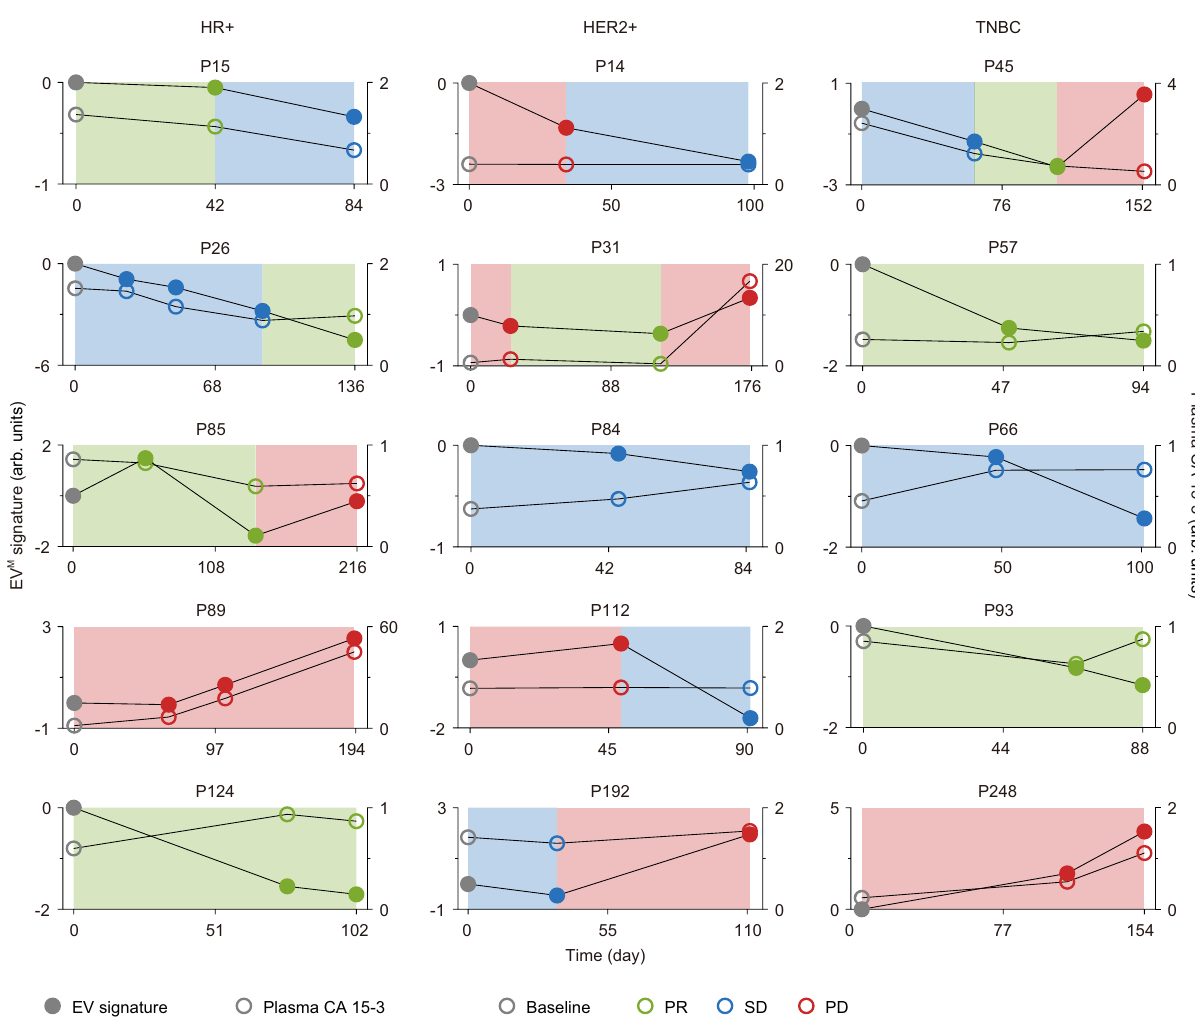
Fig. 6 Comparison of the EV M signature and plasma CA 15-3 in longitudinal monitoring for MBC. The EV M signature, CA 15-3 level, and therapeutic response were summarized for MBC patients in different BC subtypes ( n = 5 for each subtype). The cumulative sum of the EV M signature at each time point was calculated and plasma CA 15-3 level was normalized by the cutoff value of 25 U mL − 1 . The solid gray, green, blue, and red dots indicate the EV M signature at the baseline, PR, SD, and PD, respectively. The void gray, green, blue, and red dots indicate the plasma CA 15-3 at the baseline, PR, SD, and PD, respectively. Source data are provided as a Source Data fi center were locally heated by a 1480-nm laser (Changchun Laser Optoelectronics Technology, China) with a power of 190 mW for 10 min to allow size-dependent enrichment of EVs. The fl uorescence intensities before and after laser irradiation were captured by a sCMOS (95B, Photometrics, Canada) with 2× 2 pixels binning and an exposure time of 50ms, and recorded using ImageJ (1.52a, NIH). The experiments were performed in the dark to avoid photobleaching. EV titration experiments . EVs isolated from plasma of an untreated MBC patient were suspended in 1× PBS at different concentrations ranging from 3.2× 10 6 mL − 1 to 10 10 mL − 1 and incubated with Cy5-conjugated single-stranded DNA (ssDNA, 0.1 μ M) aptamers targeting CEA at 25°C for 2 h. TAS was then used to detect the expression level of CEA on EVs with different concentrations. As shown in Fig. 1e, TAS exhibited a linear response for EVs in the range between 1.6 ×10 7 mL − 1 and 10 10 mL − 1 ( R 2 = 0.93). A limit of detection (LoD, 3× standard deviation above the blank) of 3.8× 10 7 mL − 1 was obtained by TAS, which is more than 10 2 -fold lower than that of ELISA. TAS detection of soluble protein markers . To determine whether soluble protein markers could be detected by TAS, three types of samples were used: (i) EV- depleted plasma diluted by 100-folds in 1× PBS; (ii) the diluted EV-depleted plasma spiked with standards of CA 15-3, CA 125, or CEA (CanAg, Sweden) at concentrations of 25 UmL − 1 , 35U mL − 1 , or 5 ngmL − 1 , respectively; (iii) sample (ii) spiked with EVs at 2× 10 9 mL − 1 isolated from plasma of an untreated MBC patient. Both TAS and ELISA were used to detect these samples (Fig. 1d).